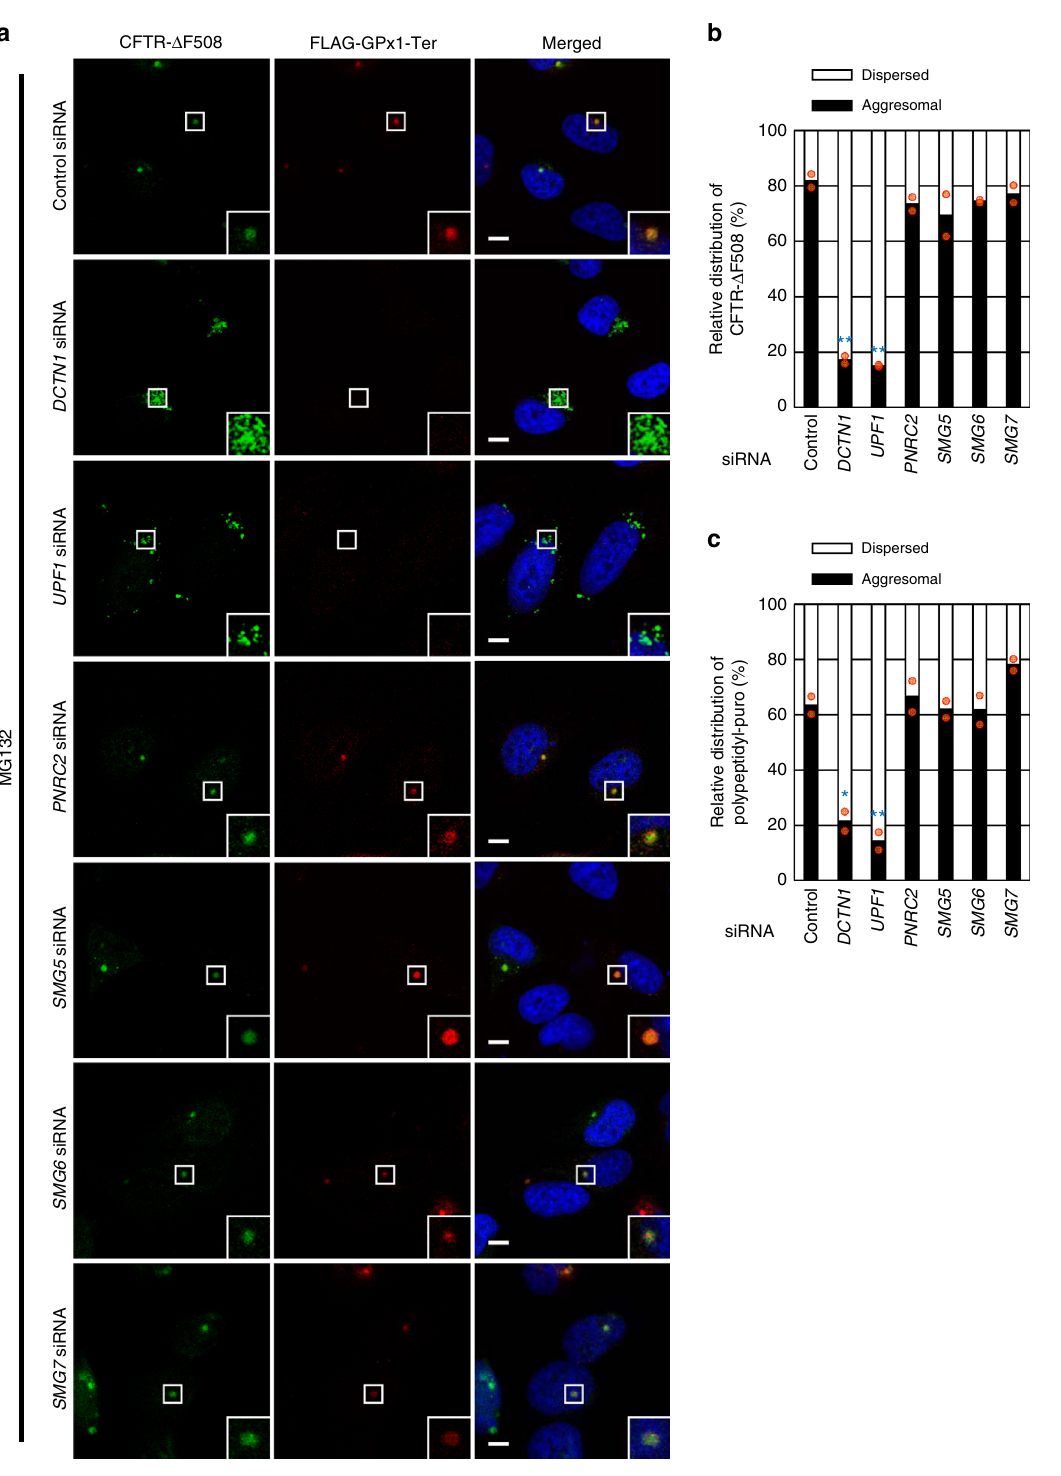
Fig. 2 UPF1 is involved in the formation of aggresome. a Immunostaining of CFTR- Δ F508 (green) and the FLAG-GPx1-Ter polypeptides (red) after downregulation of NMD factors. HeLa cells stably expressing CFTR- Δ F508 were transfected with the indicated siRNAs. Two days later, the cells were retransfected with the plasmid expressing FLAG-GPx1-Ter. The cells were treated with MG132 for 12 h before the immunostaining. Scale bar, 10 μ m; n = 2. b Relative percentages of the cells containing either the aggresome or dispersed aggregates of CFTR- Δ F508. Relative percentages of the cells were determined by counting of the cells containing either the aggresome or dispersed aggregates of CFTR- Δ F508 in the immunostaining images. Two-tailed, equal-sample variance Student ’ s t test was carried out to calculate the P values. ** P = 0.0019 ( DCTN1 siRNA) and 0.0014 ( UPF1 siRNA); More than 100 cells were analyzed from each of two independent experiments. c Relative percentages of the cells containing either the aggresome or dispersed aggregates of polypeptidyl-puro. As performed in panel b, except that immunostaining images from Supplementary Fig. 3a were analyzed. Two-tailed, equal-sample variance Student ’ s t test was carried out to calculate the P values. * P = 0.0127 ( DCTN1 siRNA), ** P = 0.0085 ( UPF1 siRNA); More than 100 cells were analyzed from each of two independent experiments. Source data are provided as a Source Data